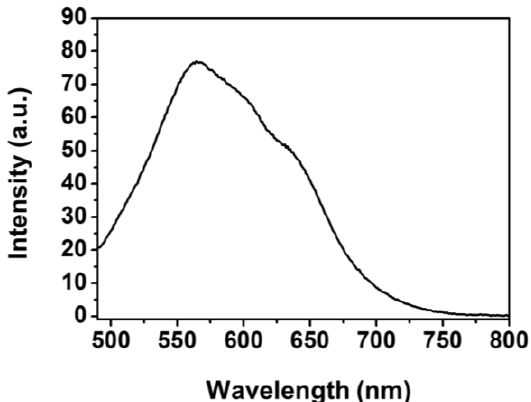
Figure 5. Photoluminescence (PL) spectra of Fe emulsion state (0.009 wt%) at an excitation wavelength of 400